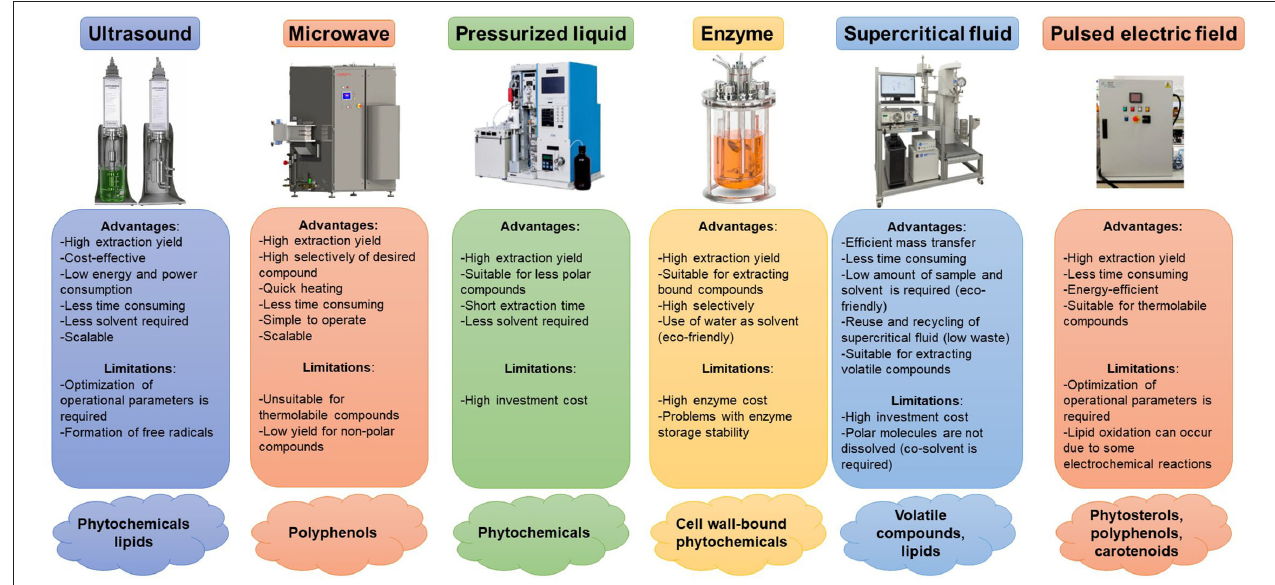
FIGURE 4 | Industrial equipment for the extraction of bioactive compounds from fruits and vegetables’ wastes and